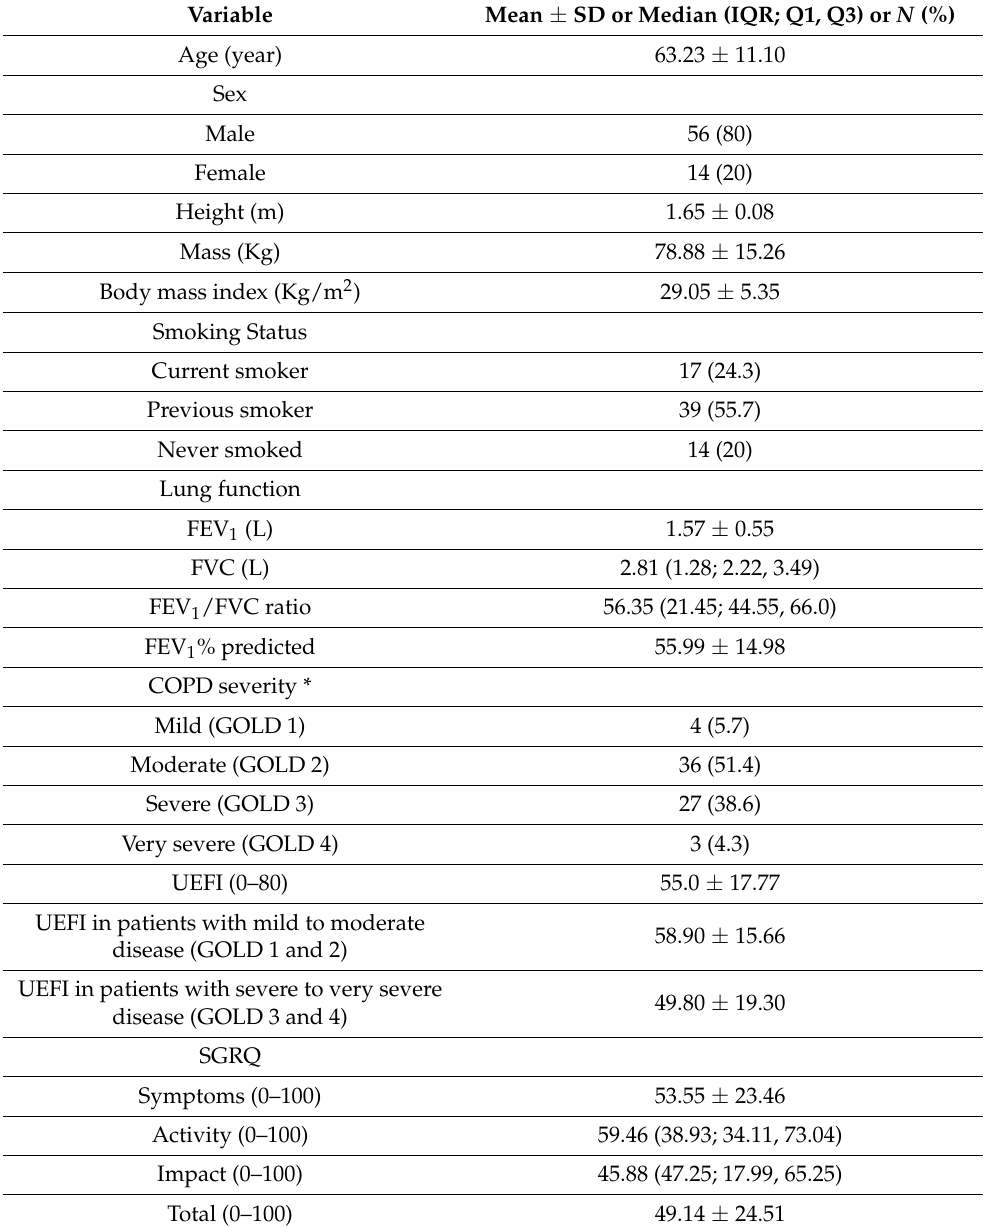
Table 1. Characteristics of participants ( N =